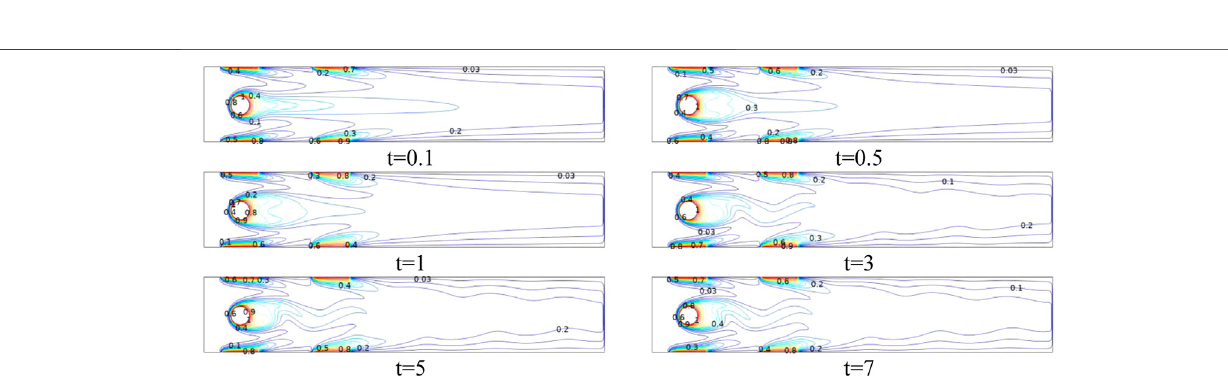
FIGURE 9 | In fl uence on isotherm for different periods with n (cid:2) 1 . 0 , Pr (cid:2) 5 , Gr (cid:2) 3 , and Re (cid:2) 100 .